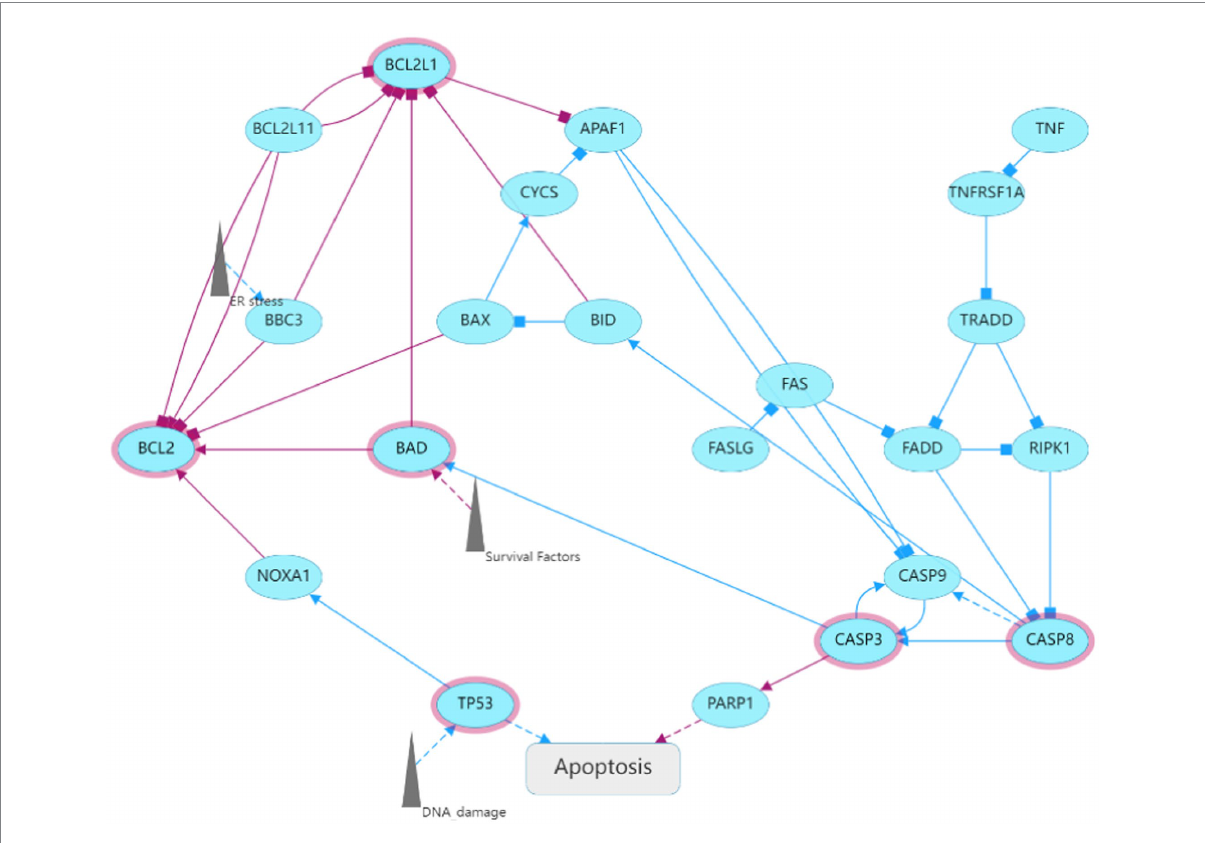
FIGURE 11 Key genes of cordycepin against AD involved in